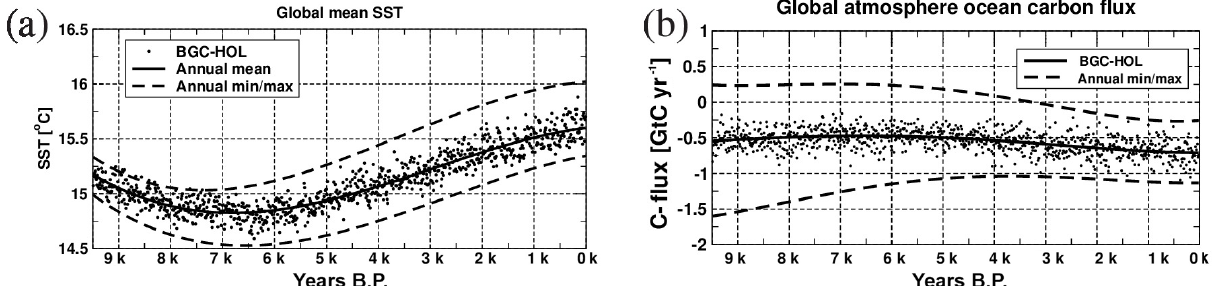
Figure A3. Time series of (a) SST and (b) atmosphere–ocean carbon flux (negative upward) for experiment BGC-HOL (black dots: annual mean values, solid black line: fourth-order polynomial fit), and annual minimum and maximum (dashed black lines, fourth-order polynomial fits), indicating the range of the annual